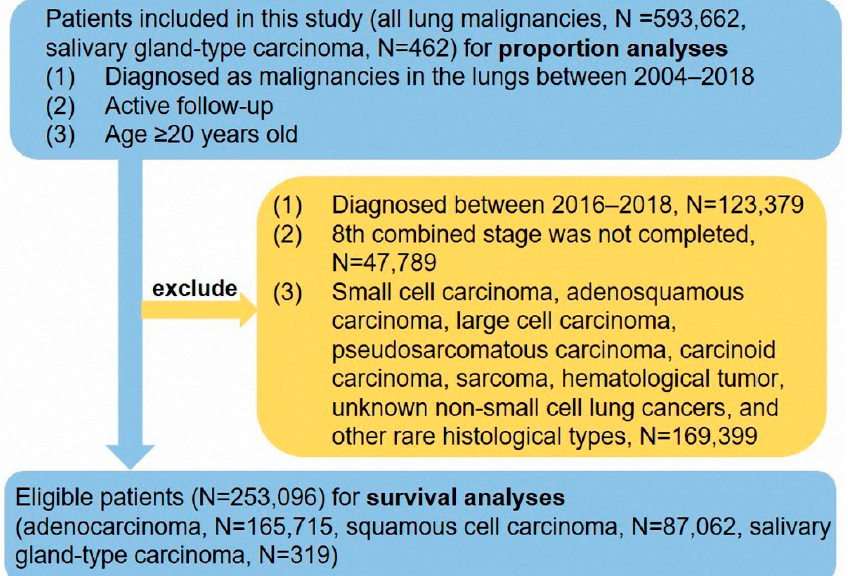
Figure 1. The flow chart of this study.